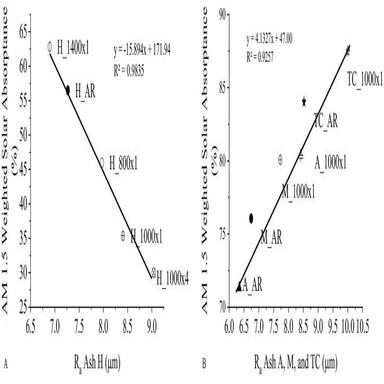
Relationship between Ra and absorptance for ash H (A) and the other thermally cycled ashes (B).